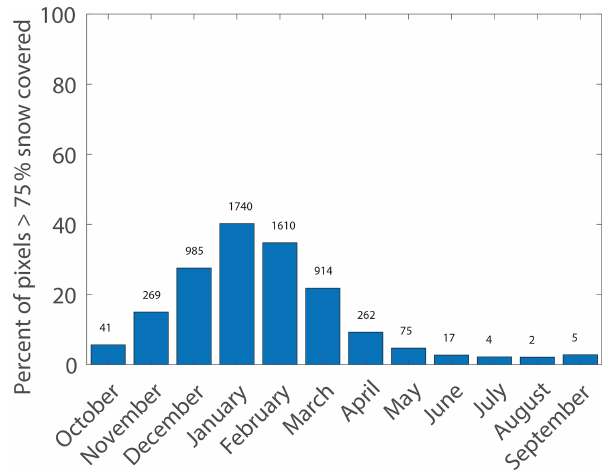
Figure 1. Percent of all snow-covered pixels with > 75% viewable fSCA in the western USA averaged from 2001 to 2021 from the spatially and temporally complete MODIS Snow-Covered Area and Grain Size (STC-MODSCAG) product (Rittger et al., 2020). The number above each bar represents the snow cover extent in square kilometers averaged over the month of measurement. Pixels corre- spond to a 463m spatial